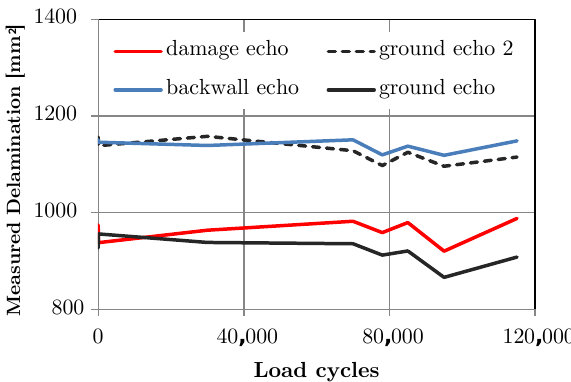
Figure 8. Evaluation of the different ultrasonic results for the sample specimen (70%